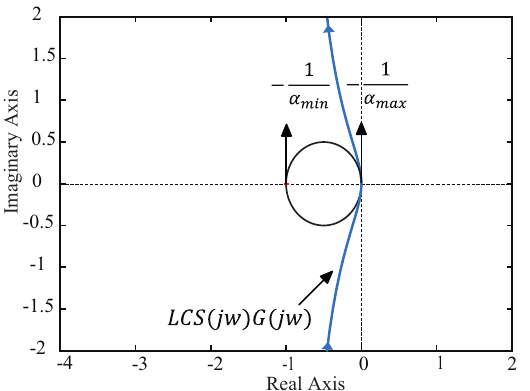
Figure 17. Asymptotic stability test for the nozzle control with the non-linear static gain and modeling uncertainty.